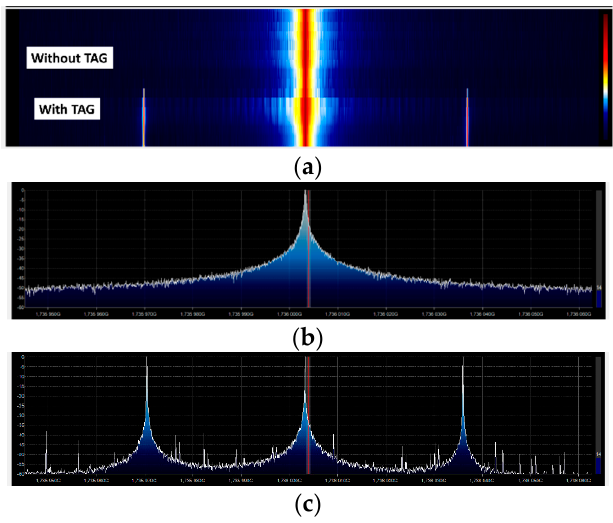
Figure 17. Screenshot of measurements with SDR# software: ( a ) spectrogram without the tag and with the tag, ( b ) cut of the spectrum without the tag, ( c ) spectrum with the tag.